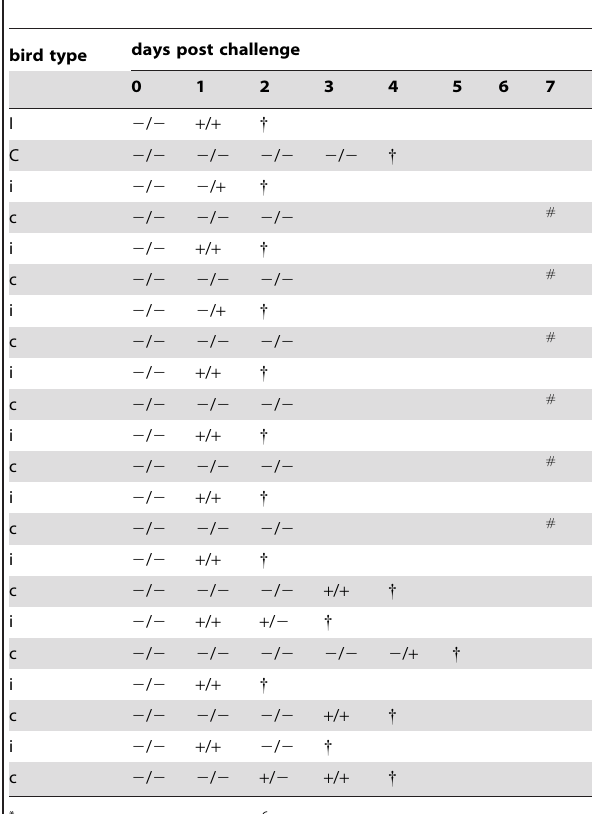
Table 2. Overview of the transmission experiment with unvaccinated birds (high infection dose)*.